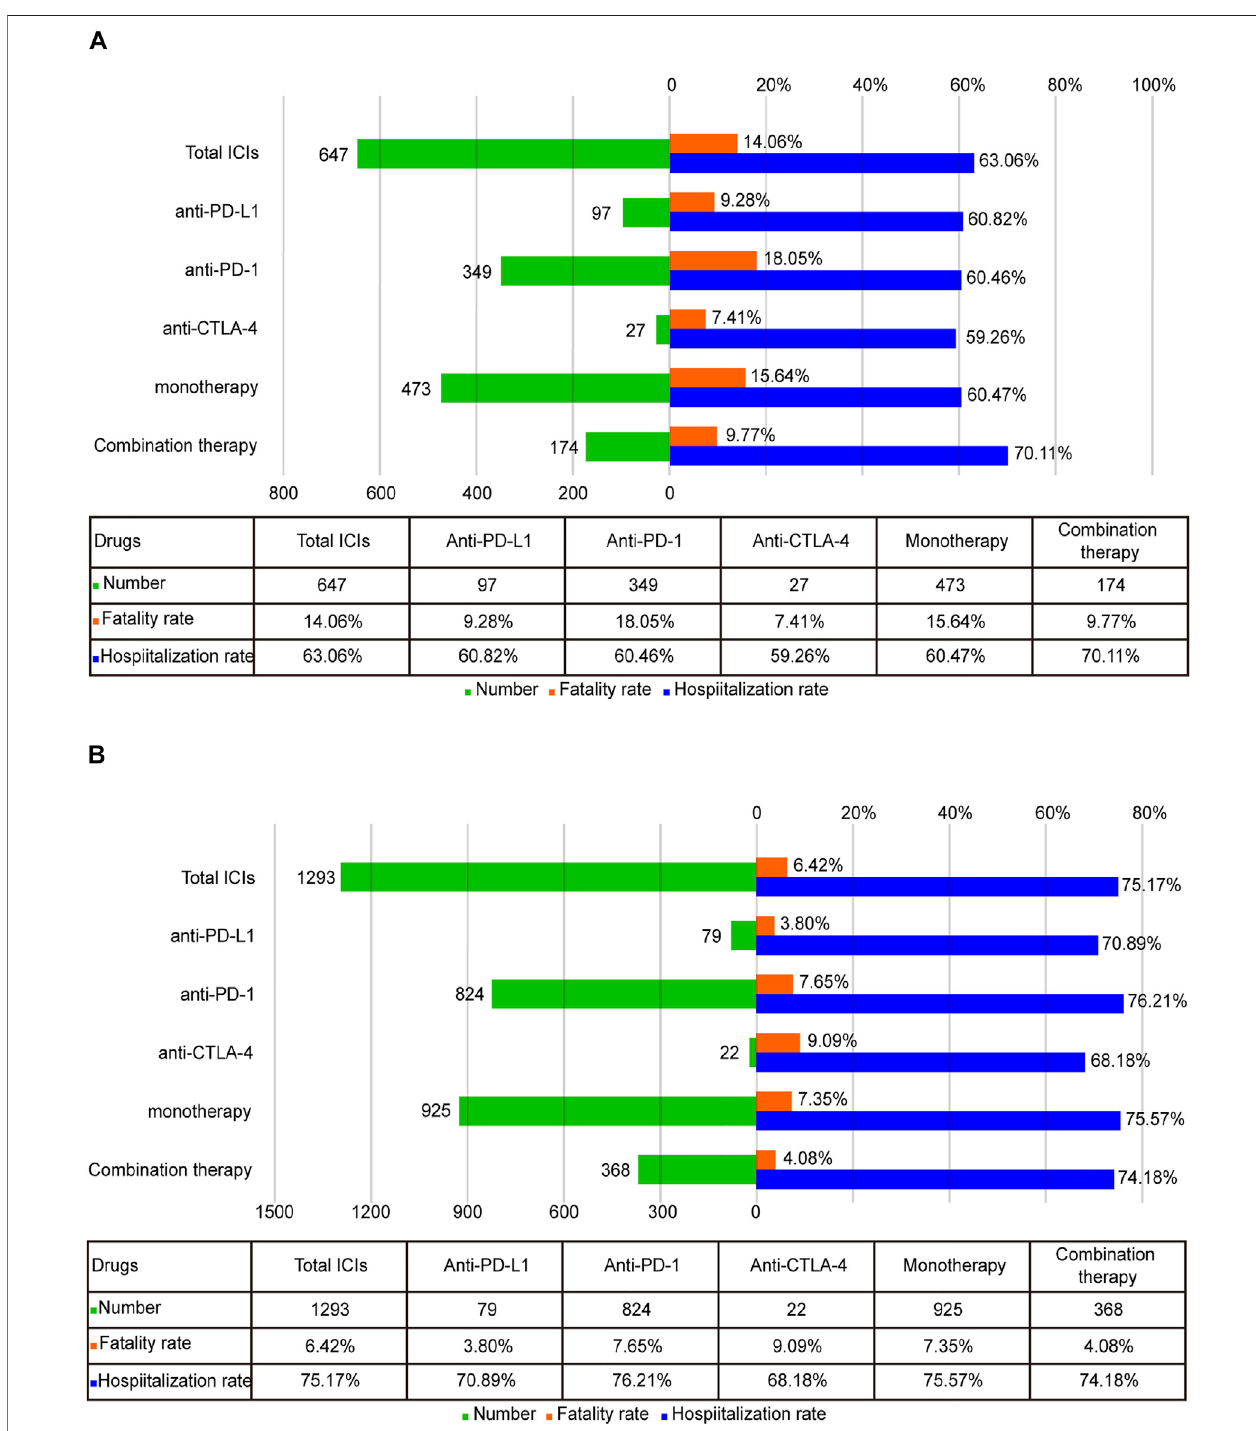
FIGURE3|(A) Thenumberofreports,hospitalization,andfatalityproportionsforICI-associatedpancreatitis. (B) Thenumberofreports,hospitalization,andfatality proportions for ICI-associated diabetes mellitus.